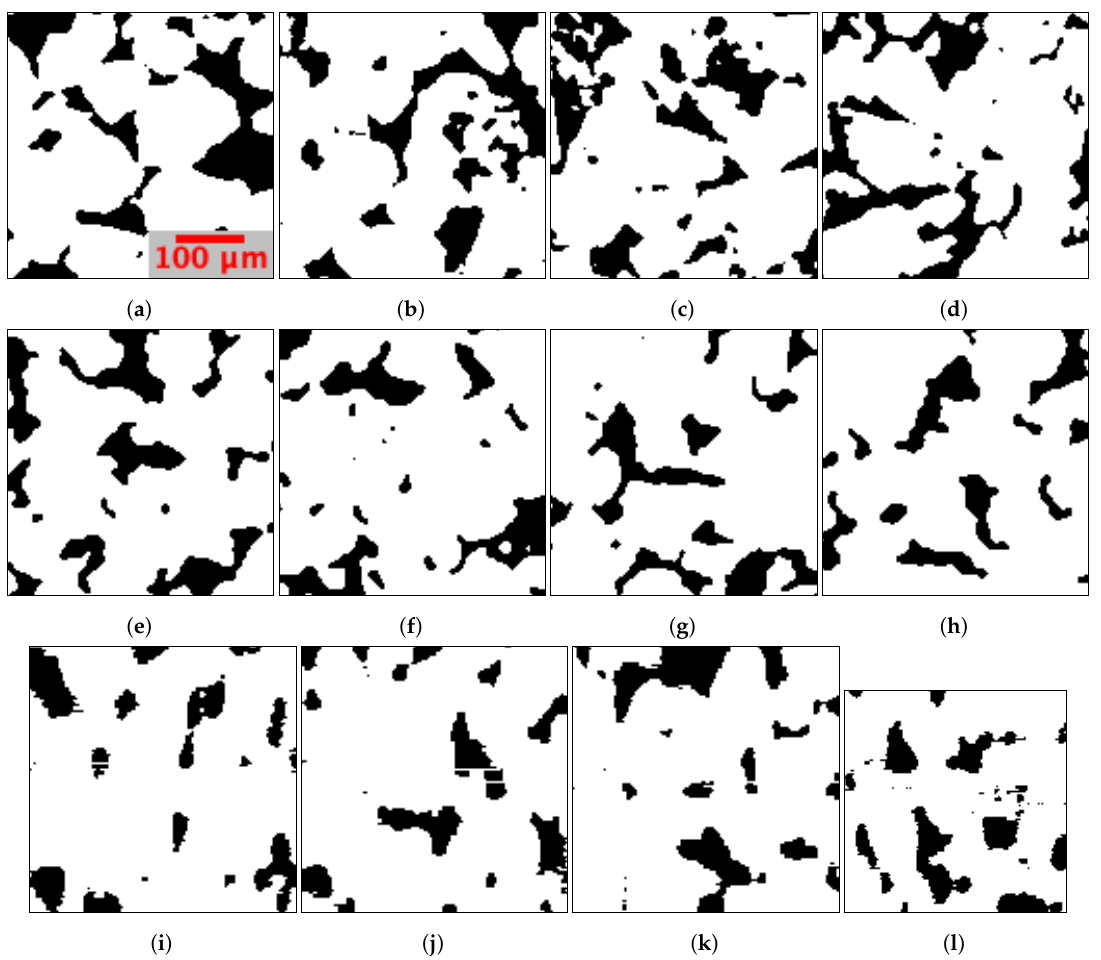
Figure 5. Berea example images with resolution at 3.0 µ m/voxel: ( a – d ) ground-truth training images in the x − y plane, ( e – h ) binarized synthetic images taken from the x − y plane, and ( i – l ) binarized synthetic images taken from the x − z